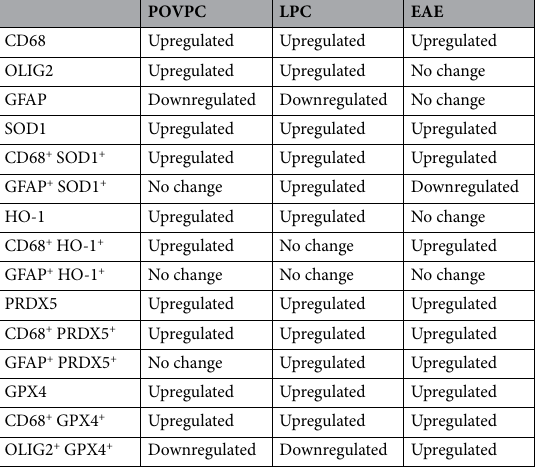
Table 1. Summary of changes in the 3 animal models of MS. This table lists the changes in the level of CD68, OLIG2, and GFAP positive cells, and their expression of particular antioxidant enzymes in the three animal models of